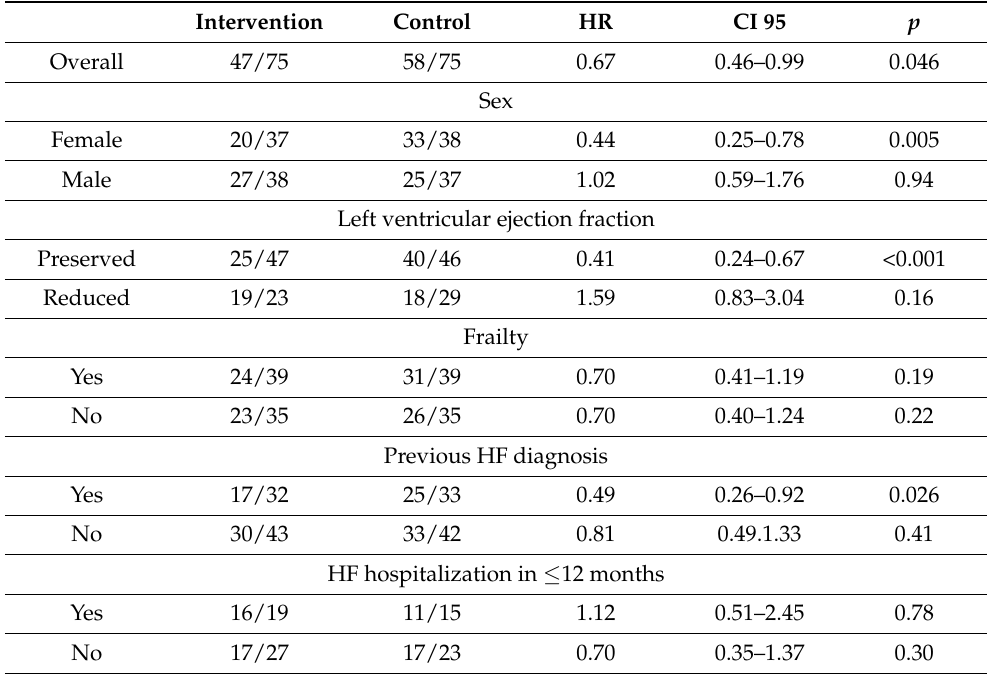
Table 4. Prespecified subgroup